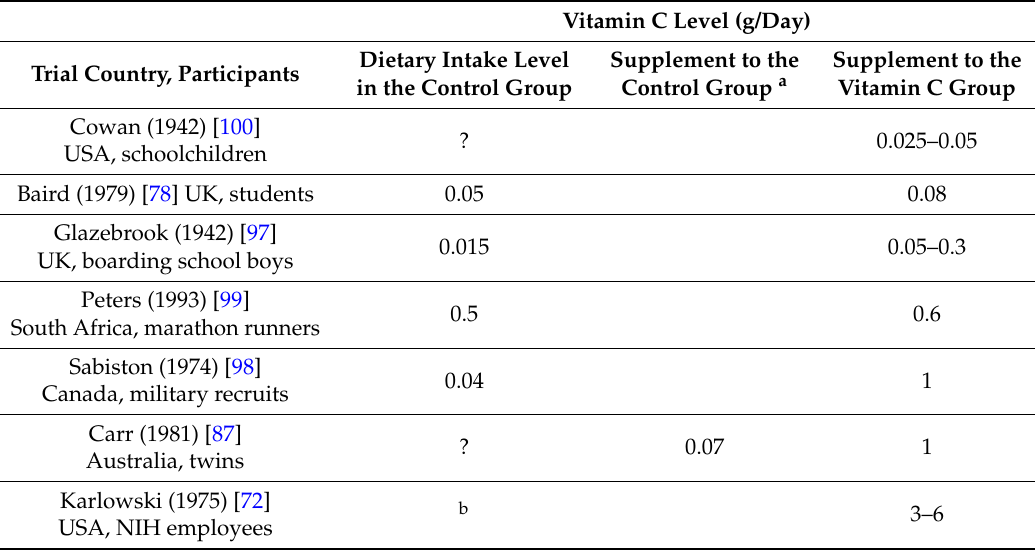
Table 6. Variations in vitamin C dose in the control and vitamin C